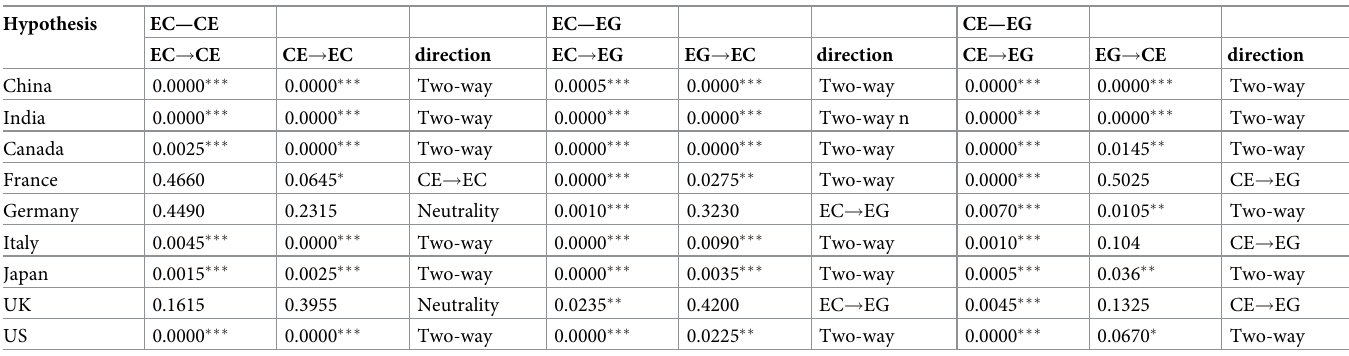
Table 3. Multispatial CCM test for the aggregate data.